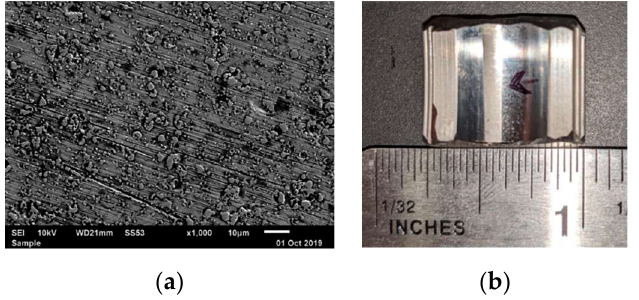
Figure 3. ( a ) EDM currents produce pits and pillars on the race surface as seen in this scanning electron microscope (SEM) image at 1000× magnification ( b ) that appears as frosting on a macro- scopic